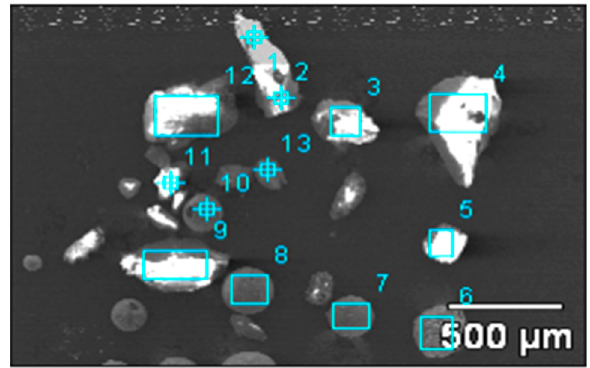
Figure 2. Morphology of large inclusions in Sample Y.